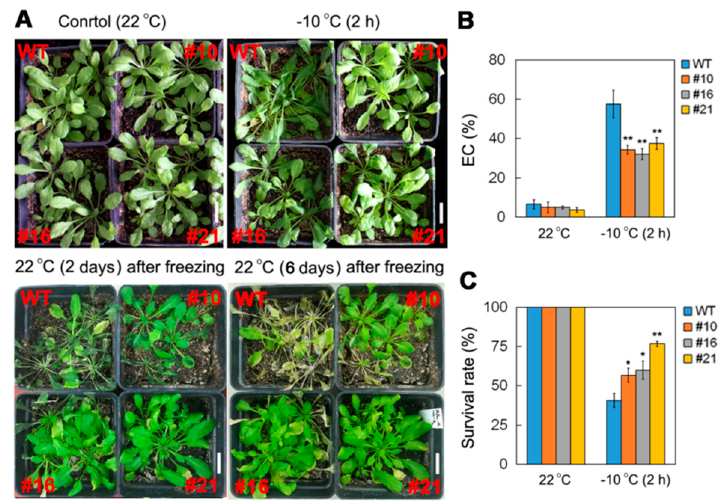
Figure 5. Comparison of phenotype ( A ), electrical conductivity (EC) ( B ), and survival rate ( C ) of WT and transgenic plants grown in soil under normal (22 °C) and freezing (–10 °C, 2 h) stress. Asterisks indicate significant differences between WT and transgenic lines (* p < 0.05; ** p < 0.01; Student’s t test). Error bars show standard error (SE) of the values from three replicates. Scale bars = 2 cm.